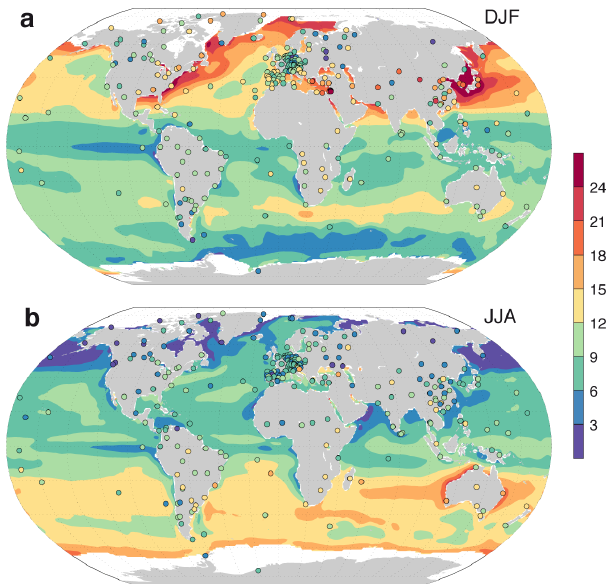
Fig. 2. Spatial distribution of predicted evaporation d (shading) and observed d in precipitation (circles). Colour shading shows seasonal mean d of ocean surface evaporation, as obtained from the regres- sion model and RH from atmospheric reanalyses, for the seasons December–February (a) and June–August (b) . Regions with sea ice in the seasonal mean are masked in white. The coloured circles show seasonal mean d of precipitation at GNIP stations. Note that evaporation and precipitation d are not expected to directly corre- spond, since precipitation d at each station is influenced by region- ally varying moisture